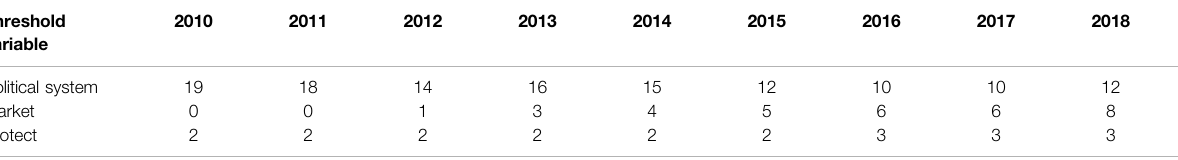
TABLE 4 | Number of provinces crossing the threshold.